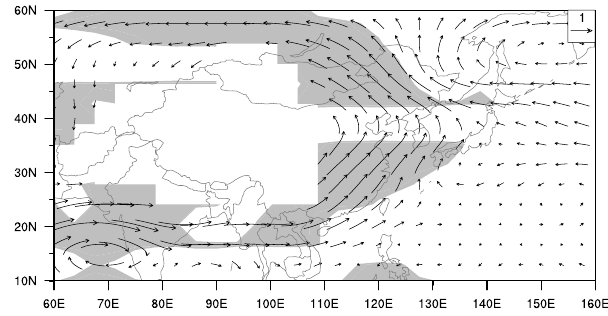
Fig. 3. Mid-Holocene–baseline anomalies of summer wind field at 850hPa (units: ms − 1 ) between AOV(6ka) and AOV(0ka) experi- ments. Regions with an elevation above 1500m are left blank, and areas exceeding 90% confidence level are